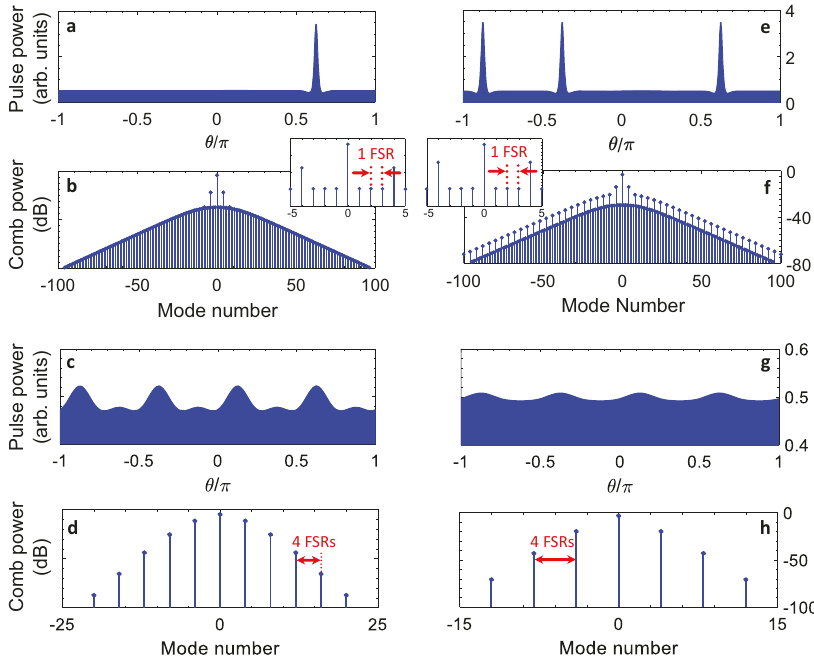
Fig. 2 Representative period quadrupling discrete time crystals in an optical Kerr cavity. Symmetry breaking and period multiplication in an optical resonator pumped by a phase-modulated continuous-wave laser, where ω M = 4 D 1 . Two different modulation depths are considered, δ M = 0.7 in a – d and δ = 0.3 in e – h . a One soliton per round-trip time emerges, resulting in discrete time-translation symmetry breaking and a 4-tupling discrete time crystal M (4-DTC). b The frequency spectrum of a , where the stronger modulation-induced frequency tones near the central pump harmonic are 4 free spectral ranges apart and soliton subharmonics fi ll in the modes between them. c , d Same as a , b , but without soliton excitation. e – h Same as a – d , respectively, but for the smaller modulation depth of 0.3. In e , f 3 soliton peaks emerge per round-trip time, but again a 4-DTC is realized. Note the different scales on the vertical axes in panels ( a , e ) compared to c , g . The insets in b , f show the frequency spectra in the immediate vicinity of the continuous-wave pump. Numerical values of integration parameters are stated in the